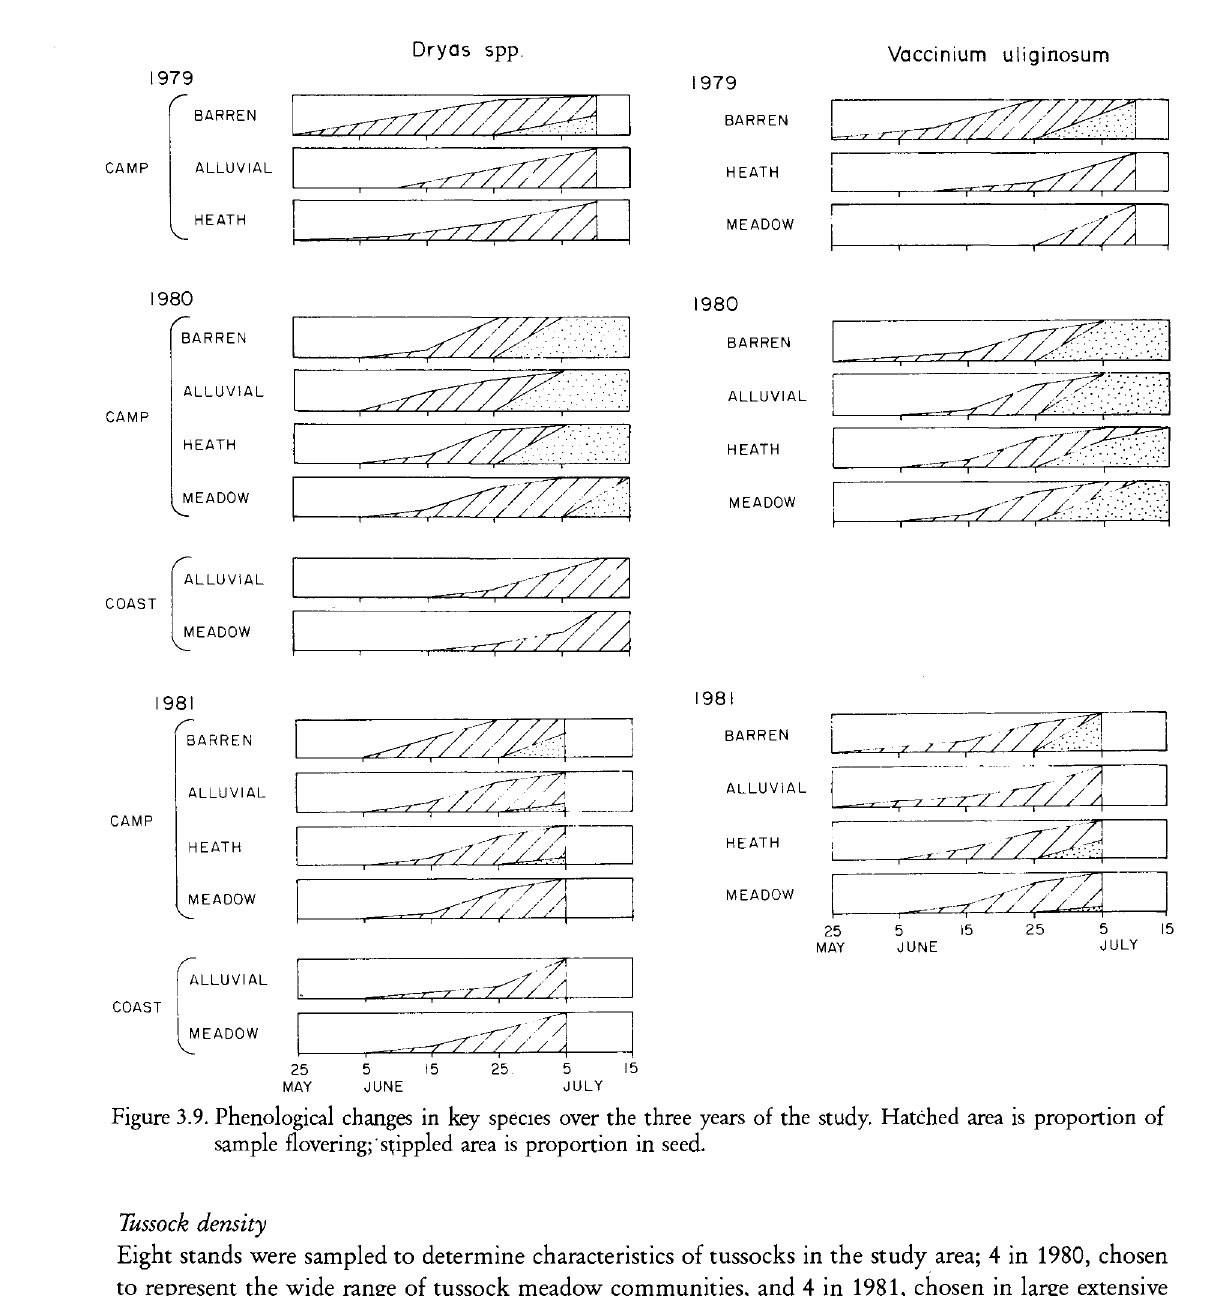
Figure 3.9. Phenological changes in key species over the three years of the study. Hatched area is proportion of sample flovering; suppled area is proportion in